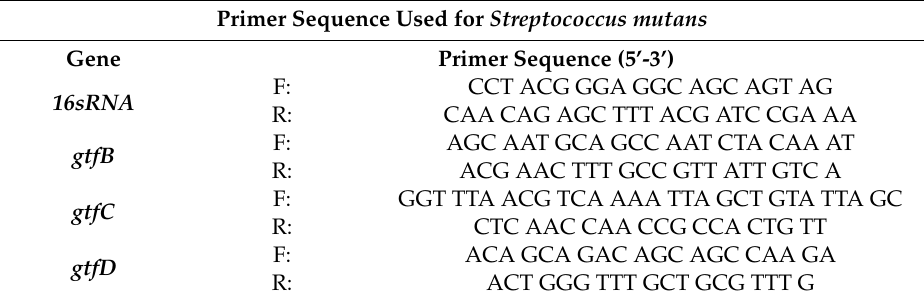
Table 1. Streptococcus mutans forward (F) and reverse (R) primers used for qRT-PCR [31]. Primer Sequence Used for Streptococcus mutans